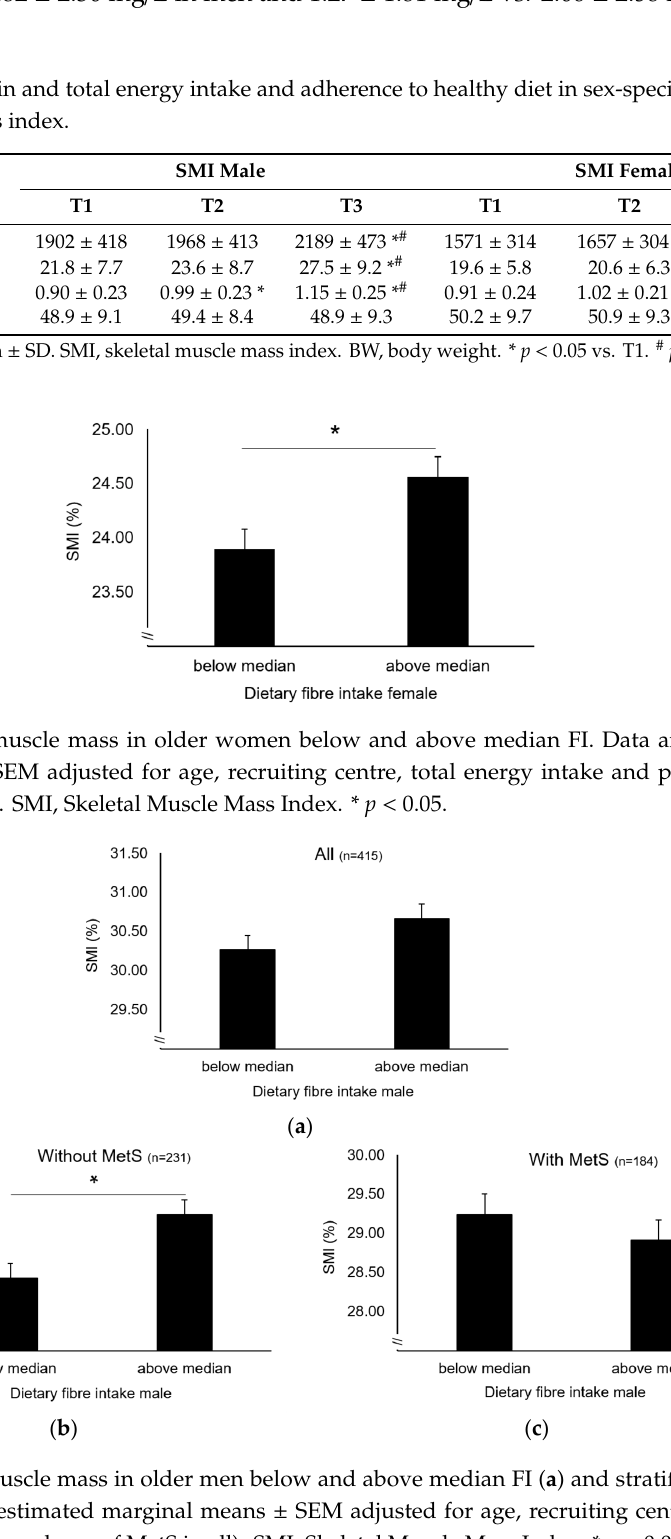
Table 3. Fibre, protein and total energy intake and adherence to healthy diet in sex-specific tertiles of skeletal muscle mass index.